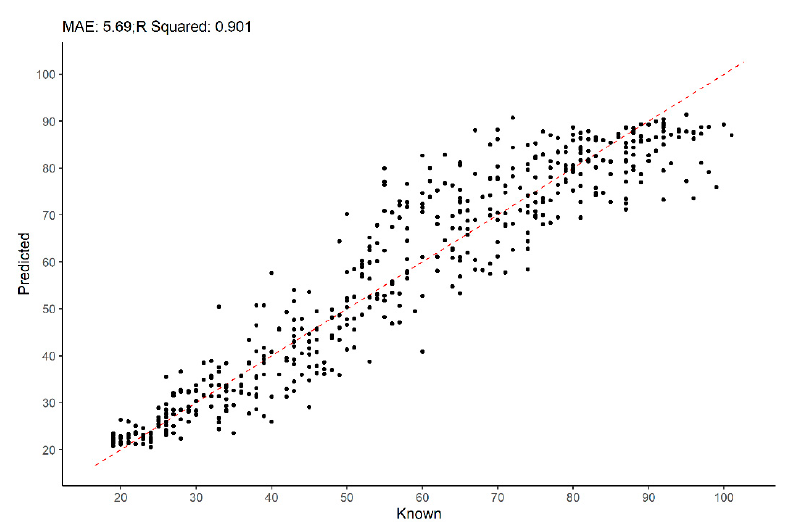
Figure 6. Known vs. predicted age-at-death using a full set of traits (LOOCV, n = 500).